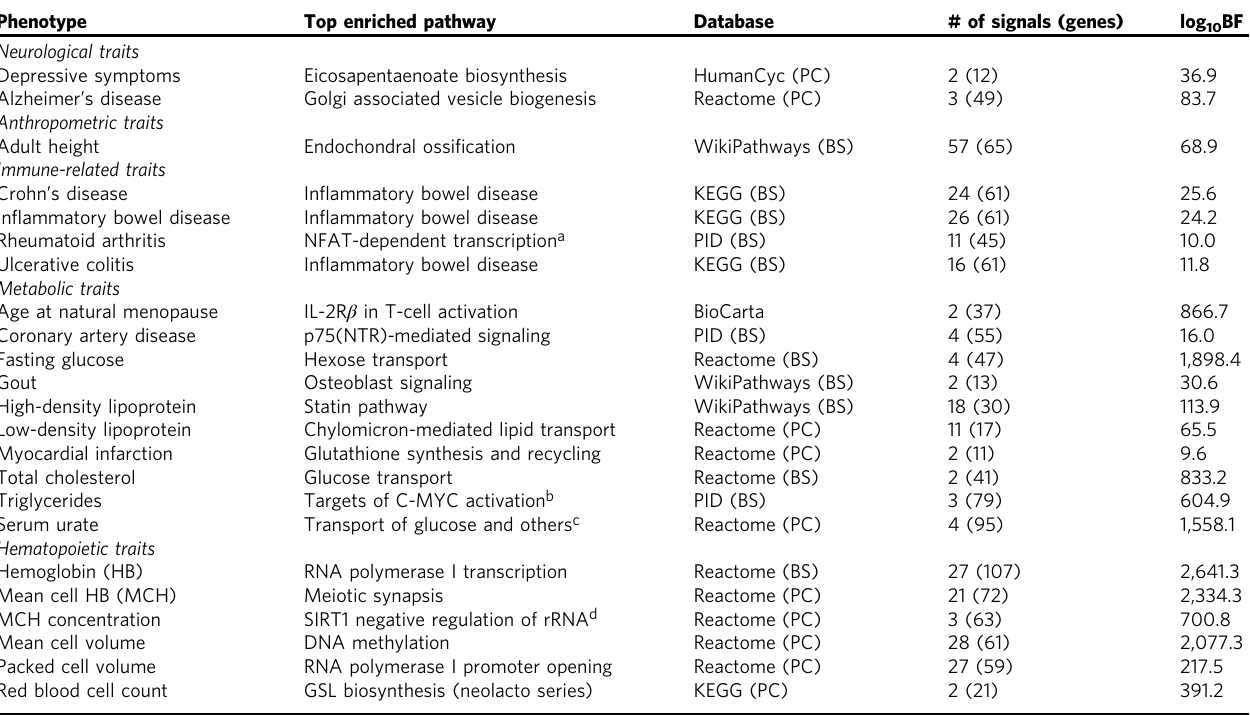
Table 1 Top enriched biological pathways in complex traits